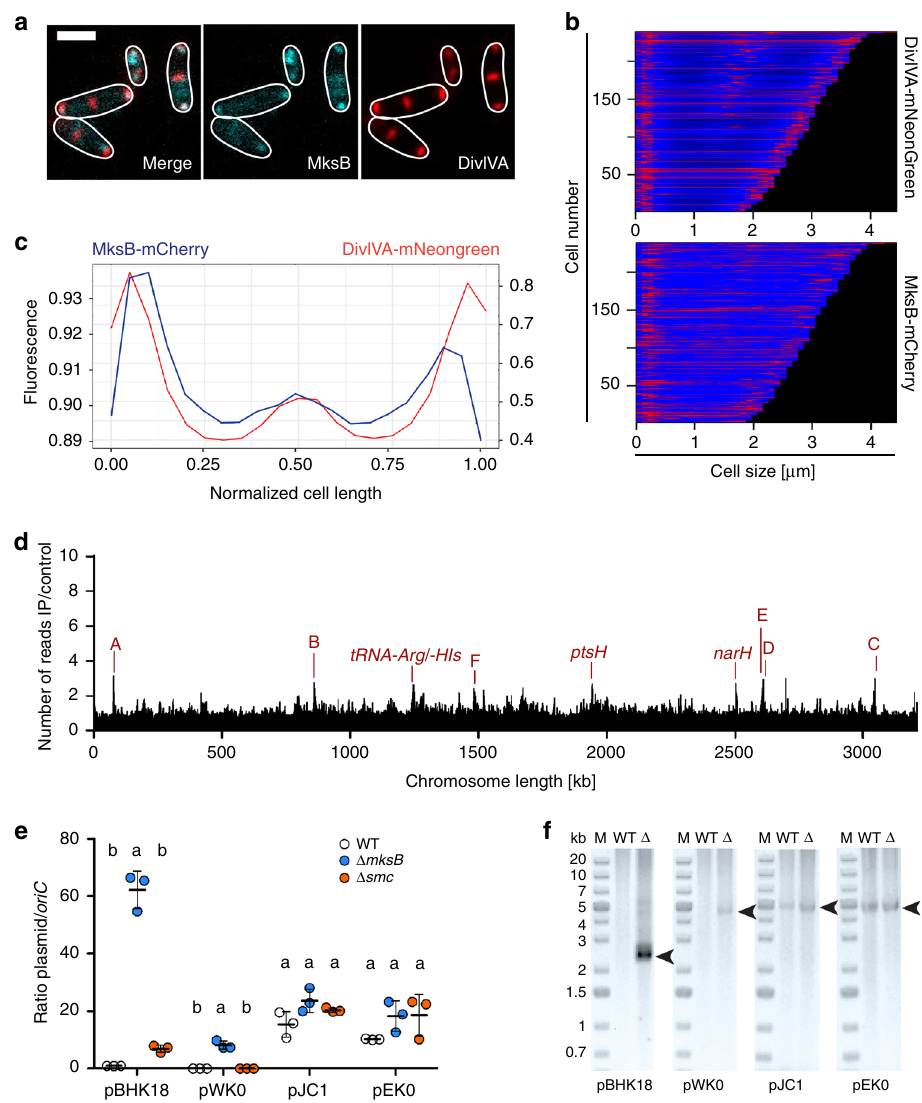
Fig. 5 MksB localizes with DivIVA and impacts on plasmid copy numbers. a Epi fl uorescence microscopy images of CBK092 cells; MksB-mCherry (cyan) and DivIVA-mNeonGreen fl uorescence (red) are shown as overlay and in separate channels; cell outlines are indicated by white lines. Scale bar, 2 µ m. b Demographs show fl uorescence pro fi les of DivIVA and MksB in strain CBK092 along cell axes sorted by length. Fluorescence intensities are illustrated relative to maximal intensity values per cell by a color gradient ranging from dark blue (low intensities) to red (high intensities). c Averaged fl uorescence (a.u.) of MksB-mCherry (blue) and DivIVA-mNeonGreen (red) along the longitudinal cell axis of CBK092 cells ( n > 200 cells). Fluorescence values of pro fi les were normalized in length and fl uorescence intensity per cell. The resulting values were then binned (bin = 0.05 µ m). d Anti-mCherry-ChIP-seq analysis of mksB ∷ mksB-mCherry strain CBK015 as described in Supplementary Fig. 4. e Plasmid copy numbers of low-copy (pBHK18 and pWK0) and high- copy number vectors (pJC1 and pEC0) relative to oriC numbers per cell, assayed by qPCR. Ratios were compared between C. glutamicum wild type, Δ mksB , and Δ smc mutant cells grown in BHI medium without addition of plasmid selection antibiotic after overnight pre-incubation with antibiotic (mean ± SD, n = 3). One-way ANOVAs yielded signi fi cant variations among strains harboring pBHK18 (F(2, 6) = 233.3, p = 2.05e − 06) and pWK0 (F(2, 6) = 98.66, p = 2.57e − 05), but not among strains harboring pEK0 (F(2, 6) = 2.496, p = 0.163) and pJC1 plasmids (F(2, 6) = 51.75, p = 0.0739). Letters indicate signi fi cant differences between data sets determined by post-hoc Bonferroni analysis at p < .05. f Plasmids named in a were extracted from C. glutamicum wild type and mksB deletion strains grown in BHI medium including selection antibiotic, visualization of extracted DNA on 1% agarose gels (corresponds to yield from ~1 × 10 9 cells each). Arrows indicate size of plasmid DNA. Source data are provided as a Source Data fi and wild-type-like MksB foci numbers per cell were detected (Supplementary Fig. 13D). Cellular MksB fl uorescence pro fi les were further extracted (Supplementary Fig. 13E) and sorted by cell length in demographs showing MksB localization at cell poles and frequently at midcell prior to cytokinesis for all conditions (Supplementary Fig. 13E, F). However, polar MksB fl uorescence tends to be more de fi ned in cell populations harboring plasmids (Supplementary Fig. 13E, F).